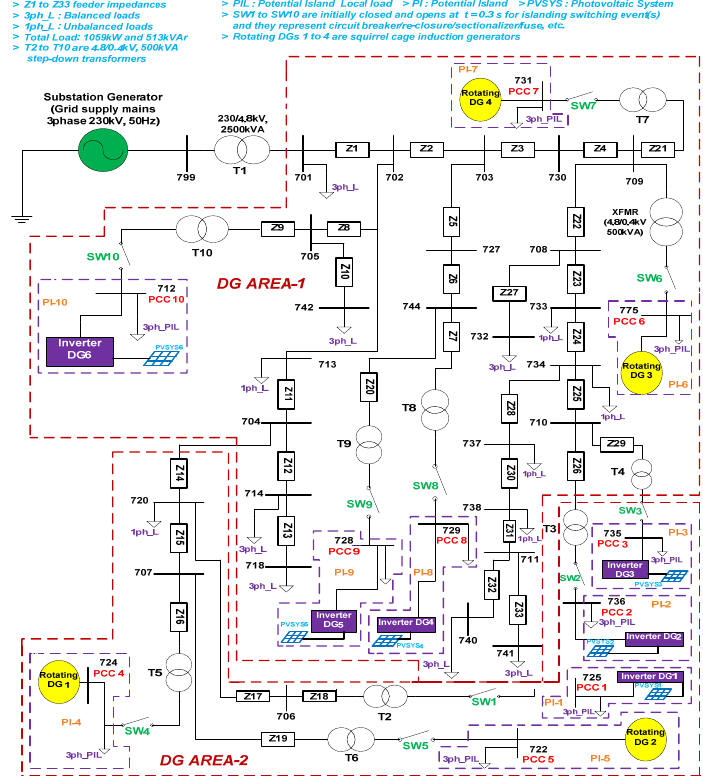
Figure 3. IEEE 34 bus distribution test feeder integrated with PV inverter and rotating DG sources.